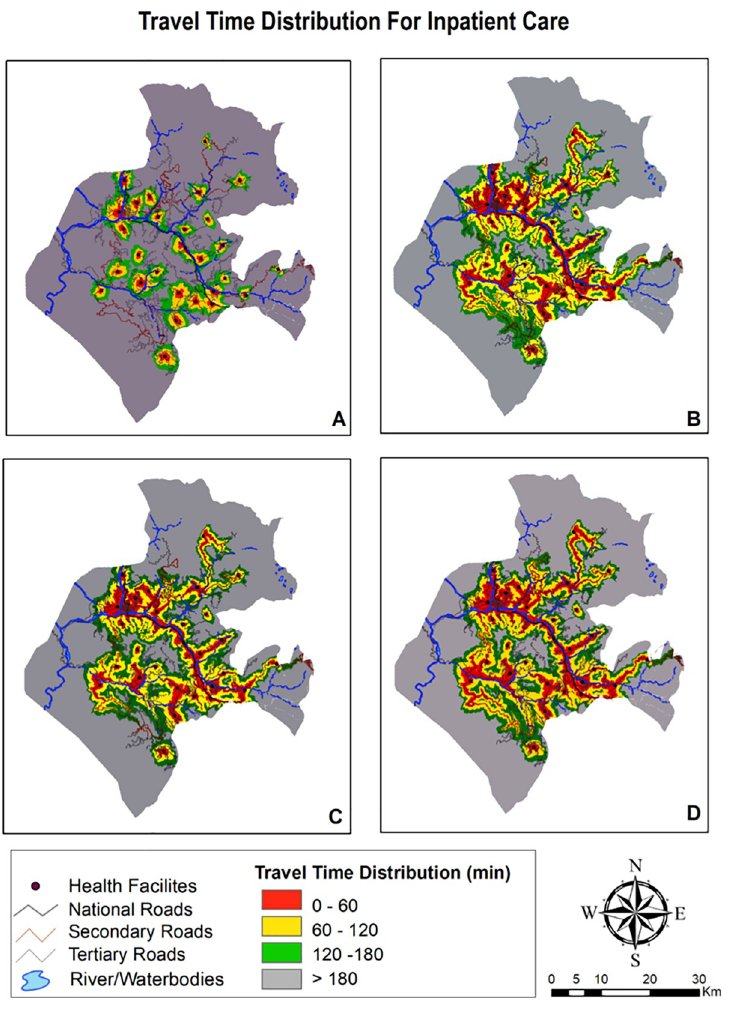
Fig 6. Mapping travel time grid for inpatient care.